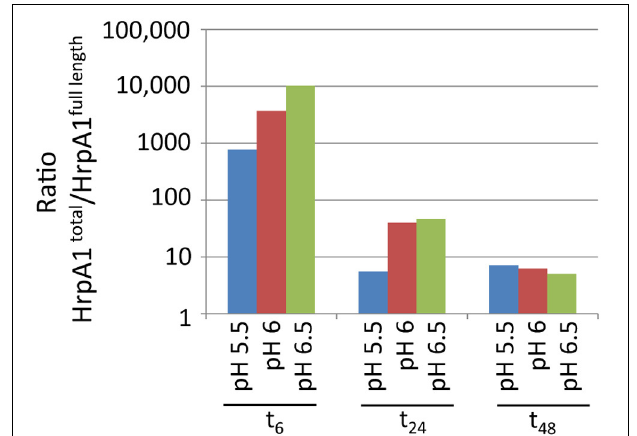
FIGURE 4 | Relative abundances over time of peptides ISATATNAK (indicating total HrpA1) and LTNLGNSAVGGVGGALQGVNTVASNA TLQK (indicating full length HrpA1) in the extracellular fractions (in semi log). Abundance ratios were determined by dividing the sum of transition pair signals of the former peptide by the sum for the latter (in arbitrary units). The equivalent ratios across 12 cell bound samples was constant at 1.62 ( ± 0.09